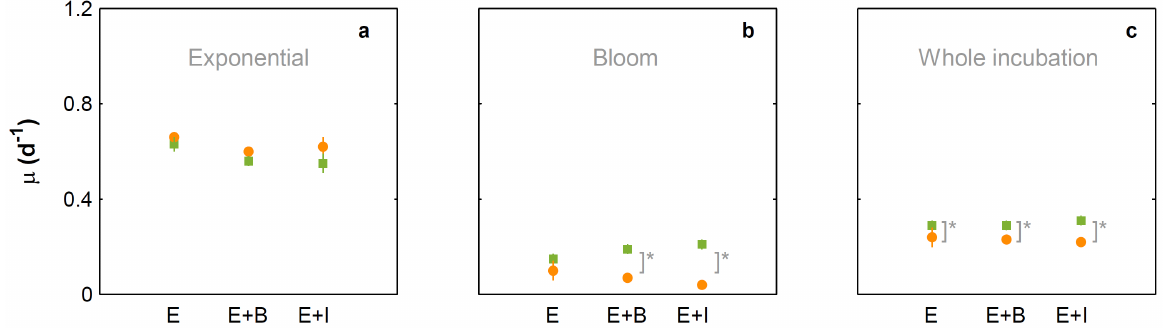
Figure 2. Growth rates based on cell counts of monocultures of E. huxleyi and E. huxleyi co-cultured with Brachybacterium sp. (E + B) and with I. abyssalis (E + I), under 475 (green) and 1056 µatm (orange). Cell division rates were calculated during the exponential (from 0 to 4 days, a ), bloom phase (from 4 to 13/14 days, b ) and whole incubation ( c ). * Denotes significant differences.